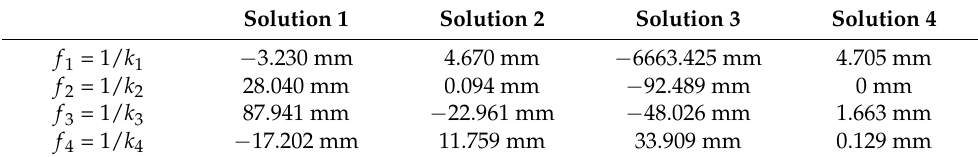
Table 2. The solutions for Equations (3) and